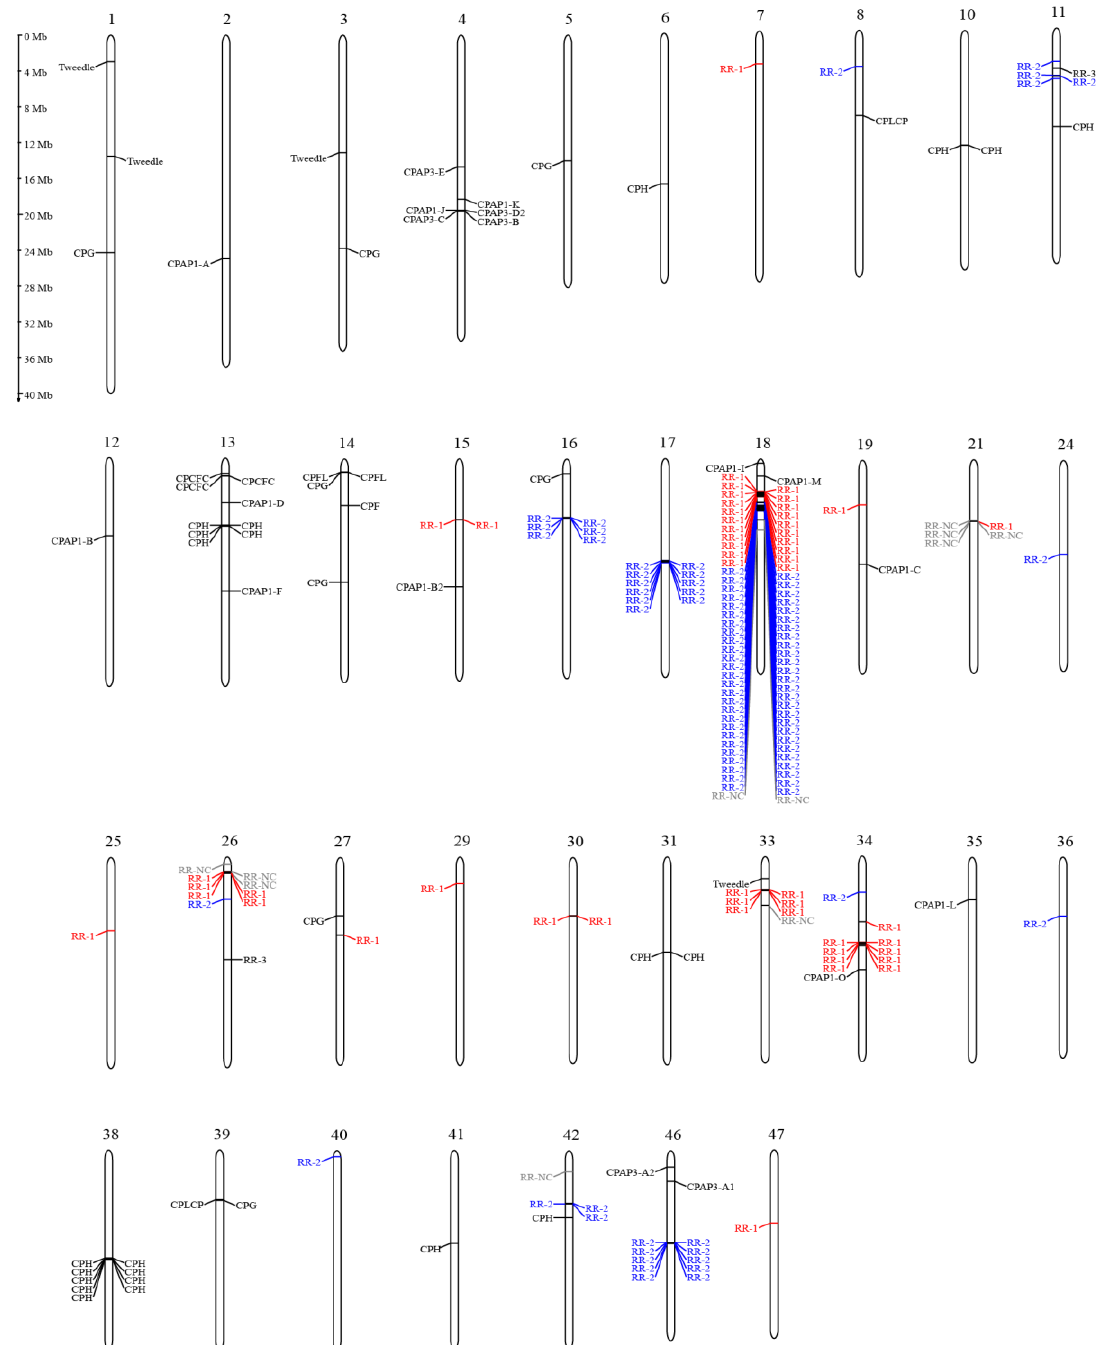
Figure 1. Chromosomal localization of cuticular protein genes in A. pernyi . (For details of the cuticular protein genes in this figure, the reader is referred to supplementary Table S3.)